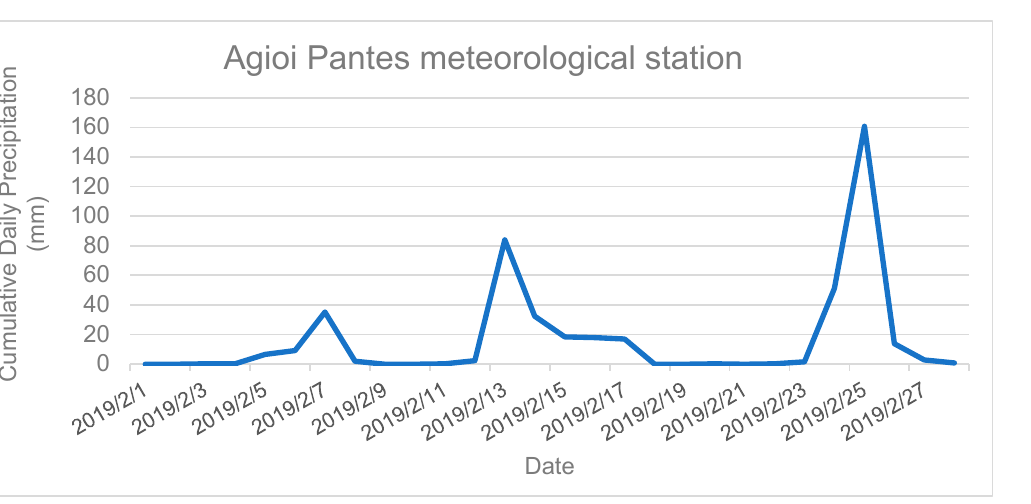
Figure 6. Cumulative daily precipitation in February 2019 recorded at the Agioi Pantes meteorological station.